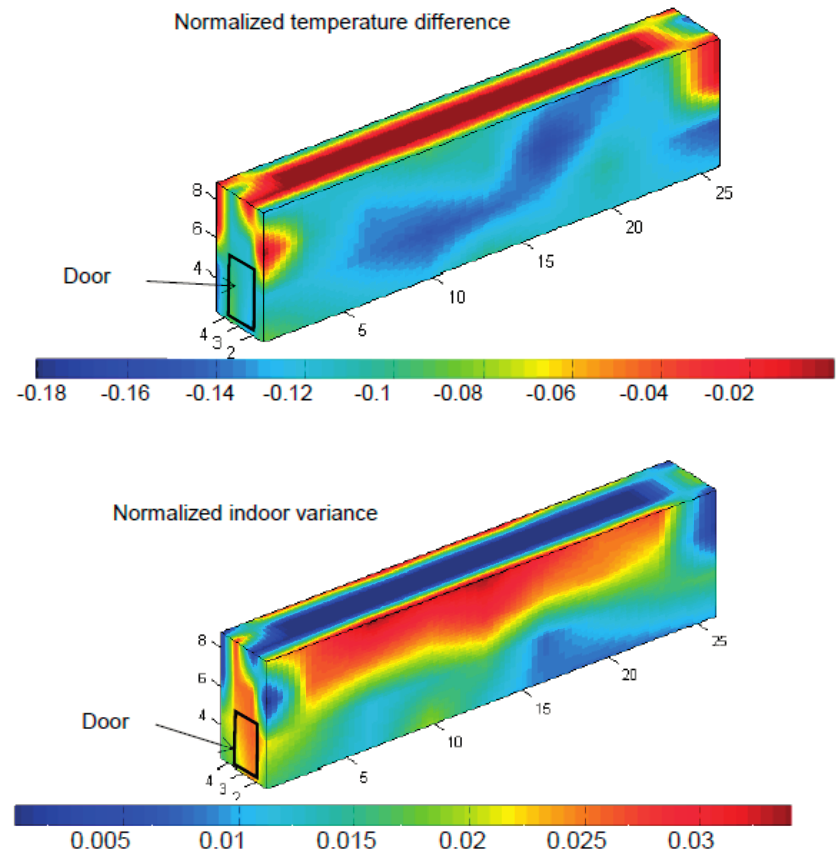
Figure 4. 3D plot of Normalized Temperature Difference and Indoor Variance in Chamber